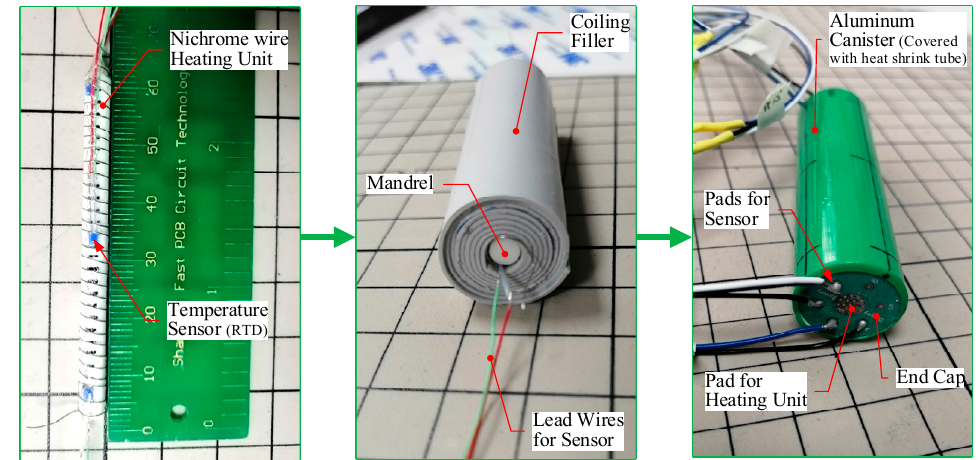
Figure 4. TDC materials and fabrication process.